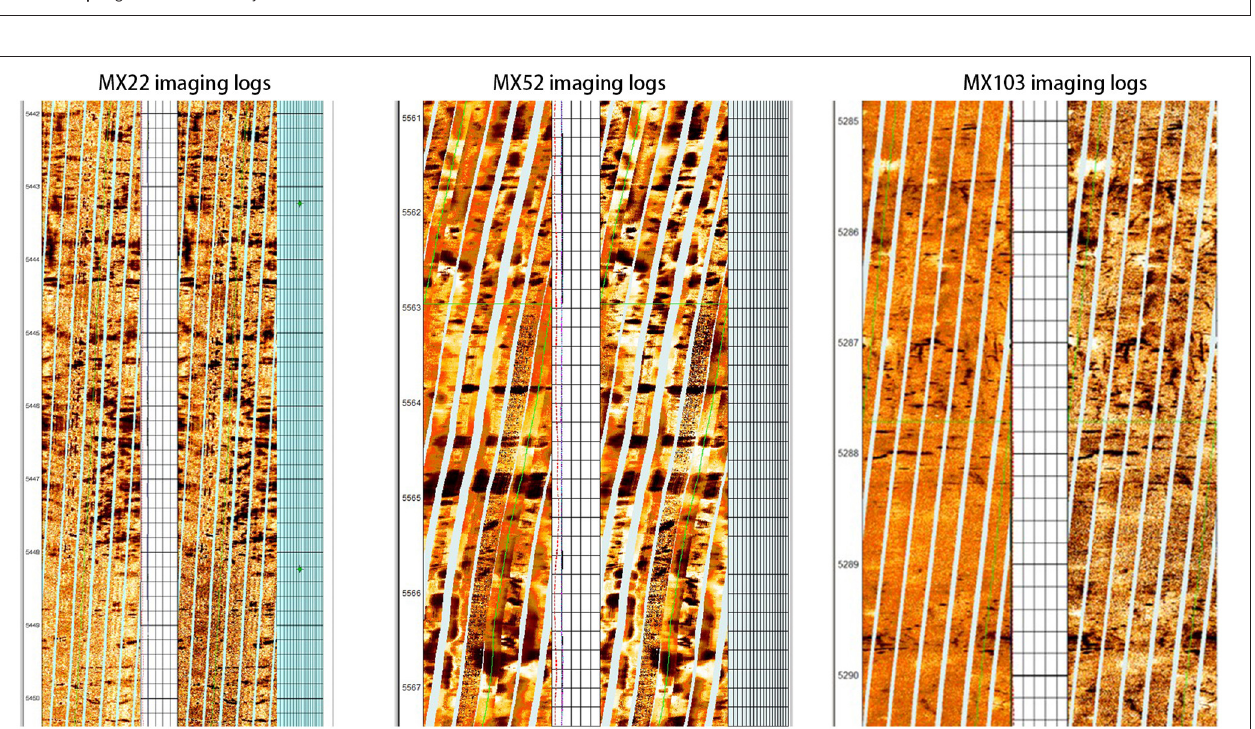
FIGURE 6 | Imaging